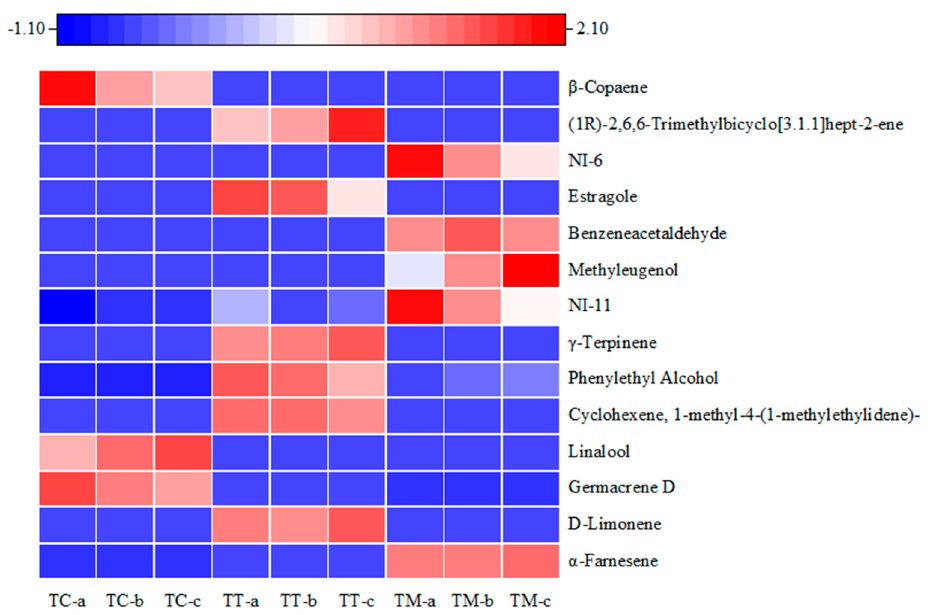
Figure 5. heat map of content distributions about 14 crucial components in the three species from Tilia .